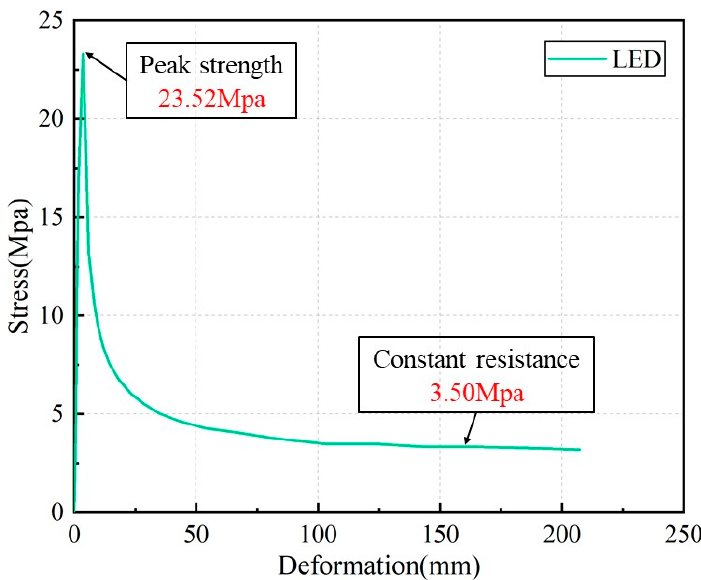
Figure 7. The stress–deformation curve of the LED.